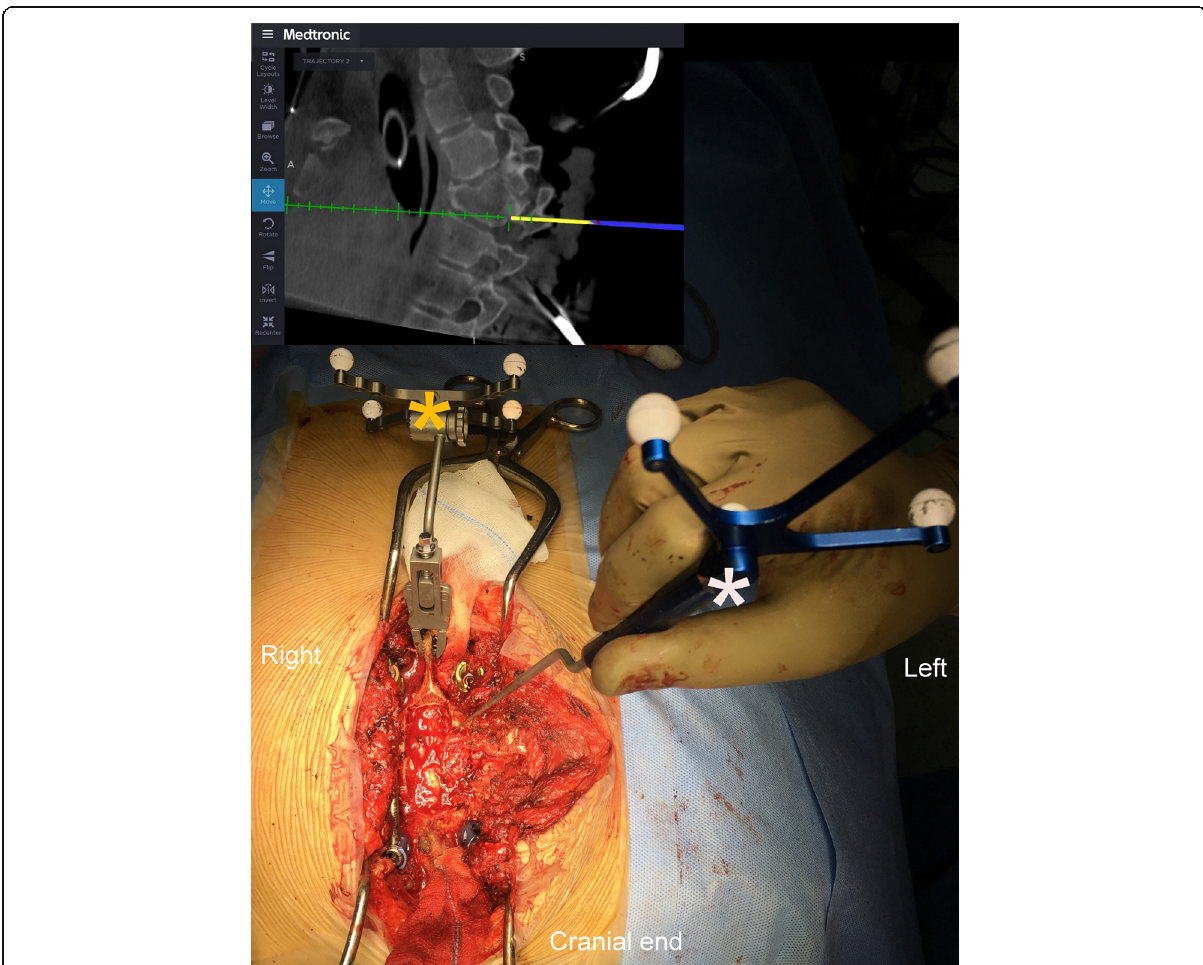
Fig. 2 Midline exposure with left lateral horizontal extension. Laminectomy was done with UBS. The rib, pedicle, and transverse processes were excised. Extra-cavitatory approach access ventrally achieved after roots sacrifices. Navigation probe (white asterisk) is being used to mark the extent of gibbus after clinical verification with Penfield probing. Navigation tracker placed caudally (yellow asterisk). Navigated probe being used (inset) to mark and confirm the extent of the planned